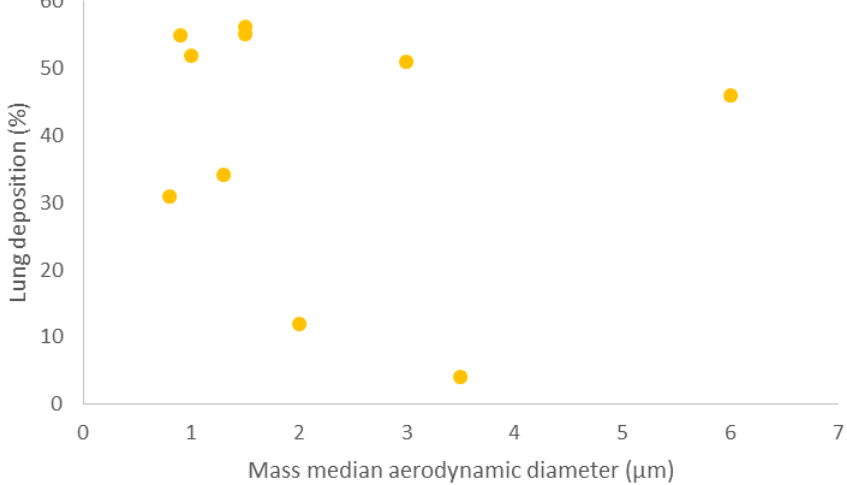
Figure 1. A scatter graph, comparing MMAD with corresponding lung deposition values in Table 4.